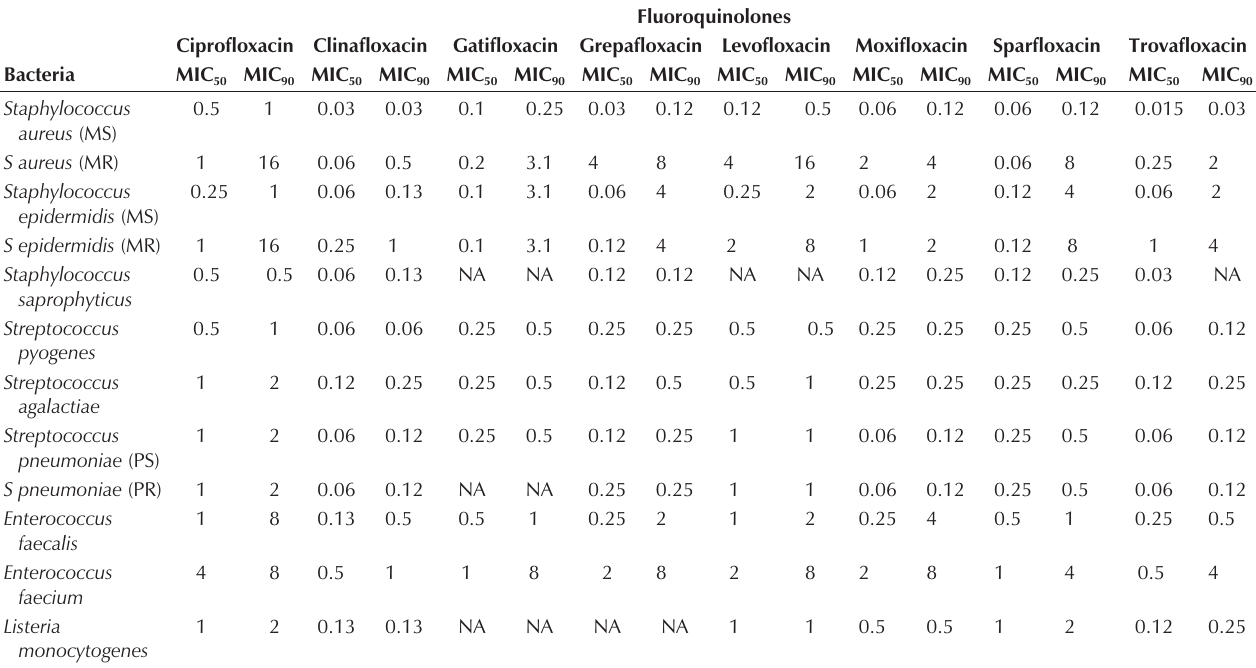
In vitro activity of the new fluoroquinolones and ciprofloxacin against Gram-positive